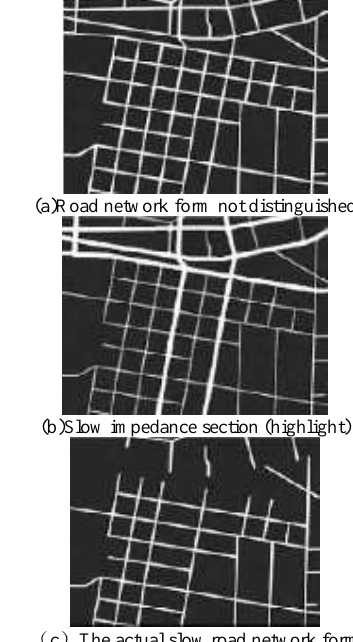
Figure 4. Road network form after removing Impedance